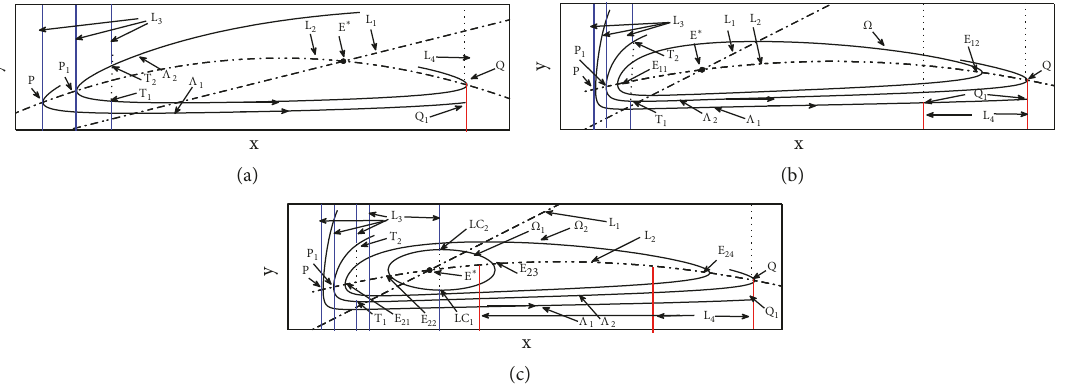
Figure 5: The definition domains of phase set and impulsive set. (a) Case (i) of Lemma 4, that is, there exists a globally stable focus of system (2). (b) Case (ii) of Lemma 4, that is, there exists a unique limit cycle Ω of system (2). (c) Case (iii) of Lemma 4, that is, there exists two limit cycles Ω 1 and Ω 2 of system (2). The blue lines represent the phase sets and the red line denotes the impulsive sets under different cases.